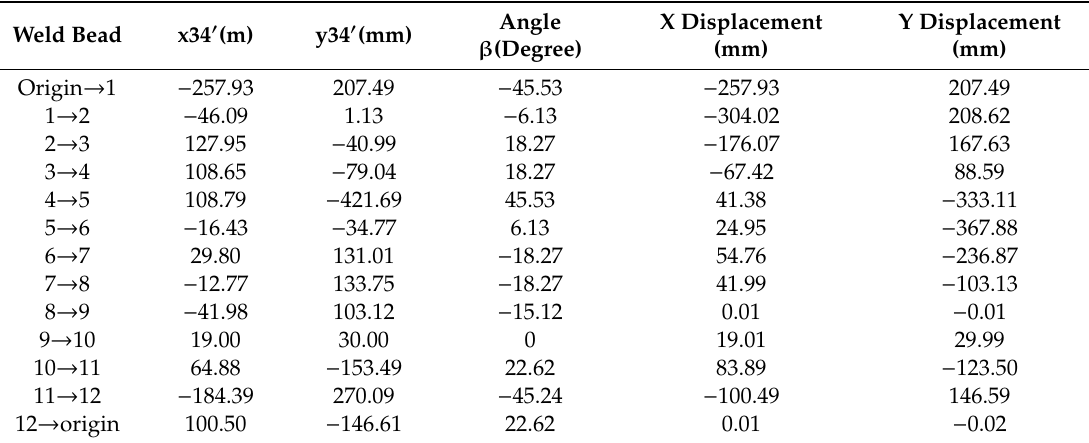
Table 4. The adjusted data of X, Y, and rotating